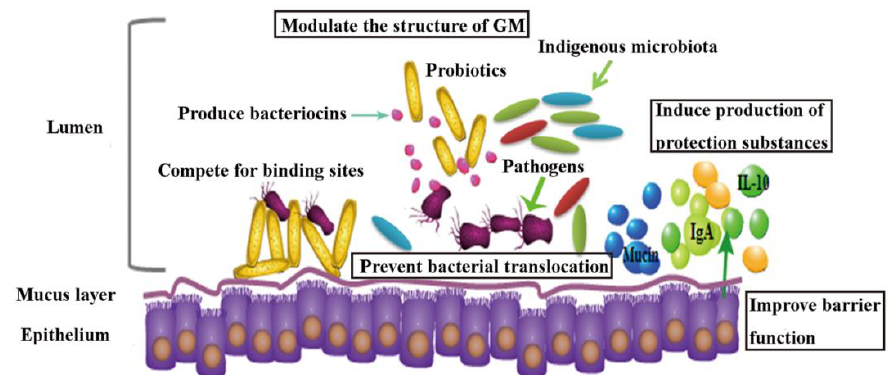
Figure 2. Schematic representation of proposed mechanisms of probiotic action on antibiotics associated diarrhea (AAD).